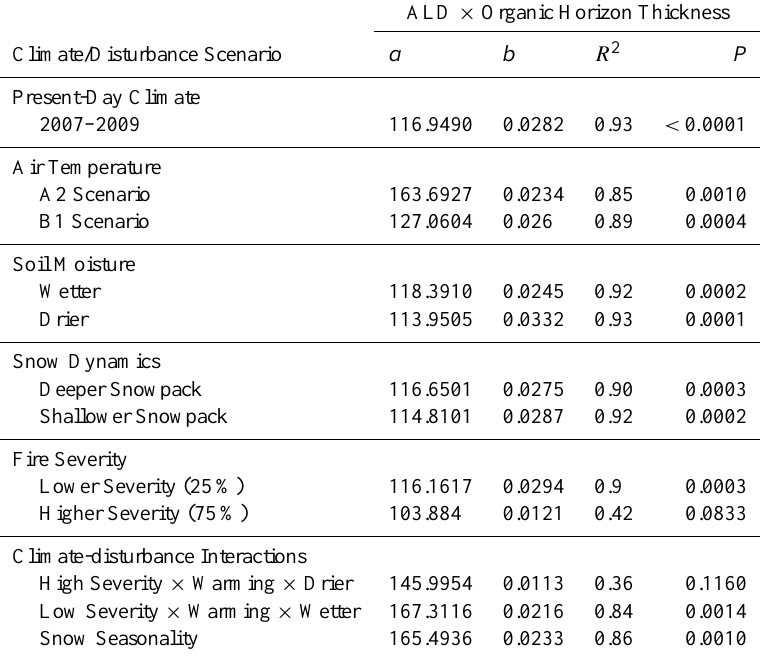
Table 4. Parameters and statistics for exponential equation ( f = ae − bx ) relating active layer depth (ALD) and organic horizon thickness across climate and fire scenarios.